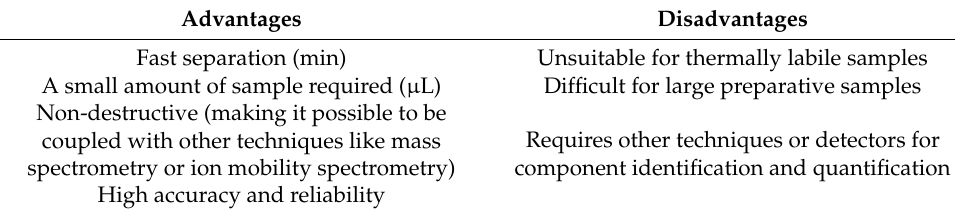
Table 1. Advantages and disadvantages of gas chromatography